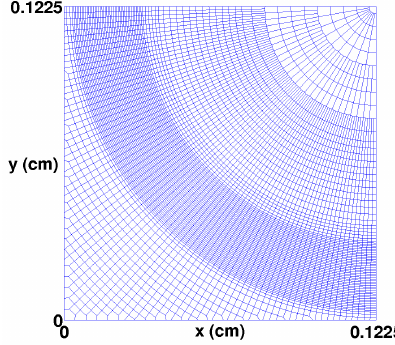
Fig. 1: Voronoi diagram used for the simulation of a skull fracture ( 5884 control